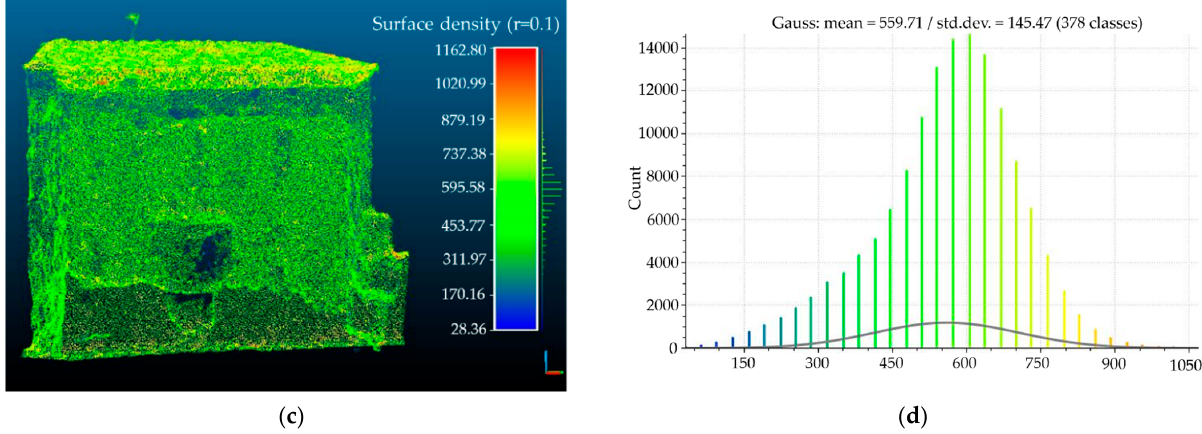
Figure 3. Point cloud density: ( a ) Building A, the majority of points present a range of neighbors 1300–1900, ( b ) histogram of density (mean = 1595 and standard deviation = 249.89), ( c ) building B, the majority of points present a range of neighbors 500–700, ( d ) histogram of density (mean = 559 and standard deviation = 145.47).